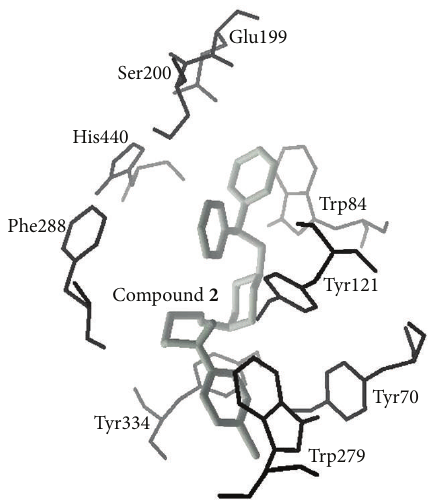
Figure 3: Docking result of the conformation corresponding to compound G inside the AChE active site. Electrostatic interactions are shown with dashed line (hydrogen bonds) and half